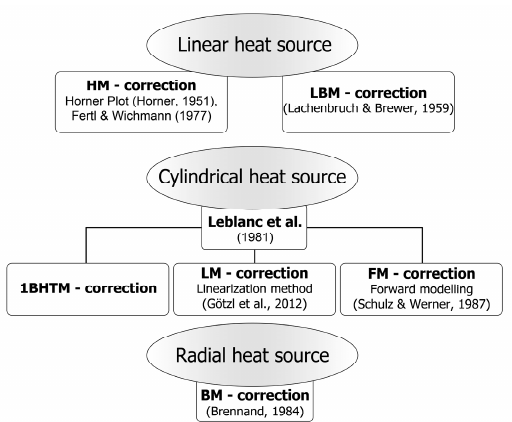
Figure 3. BHT correction methods applied for quantifying uncertainty, HM [10,46], LBM [12], the two correction methods based on [18], LM [47] and FM [20] and BM [15].